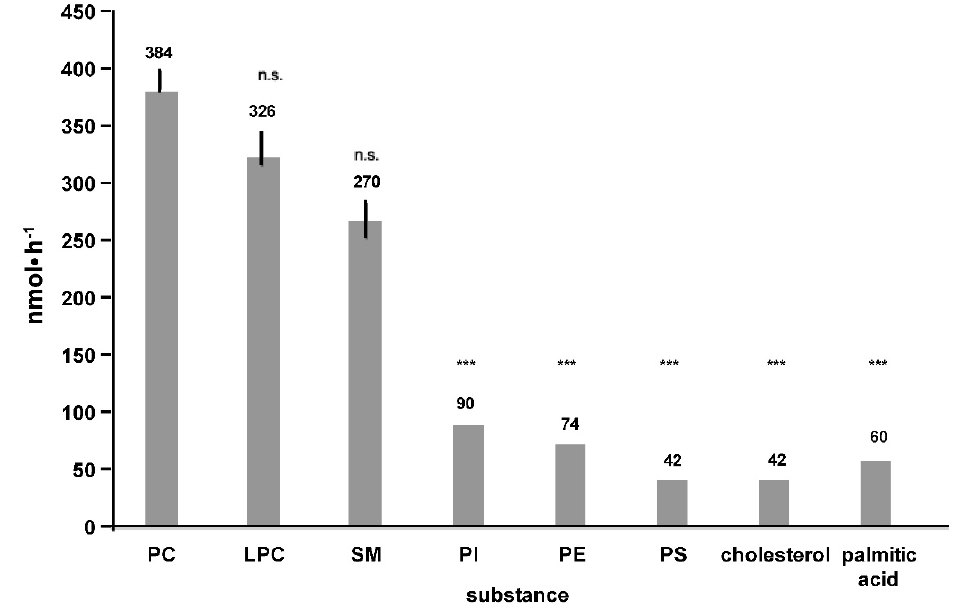
Figure 5. Specificity of apical transport for choline-containing phospholipids in polarized, nine-day cultured Mz-ChA-1 cells. Apical transport was examined for 1 h after basal application of the different substrates at 10 mM phosphatidylcholine (PC) together with 10 mM taurocholate (TC). Means ± SD of n = 6. Significances were calculated in relation to PC; n.s. = not significant, *** p < 0.001.